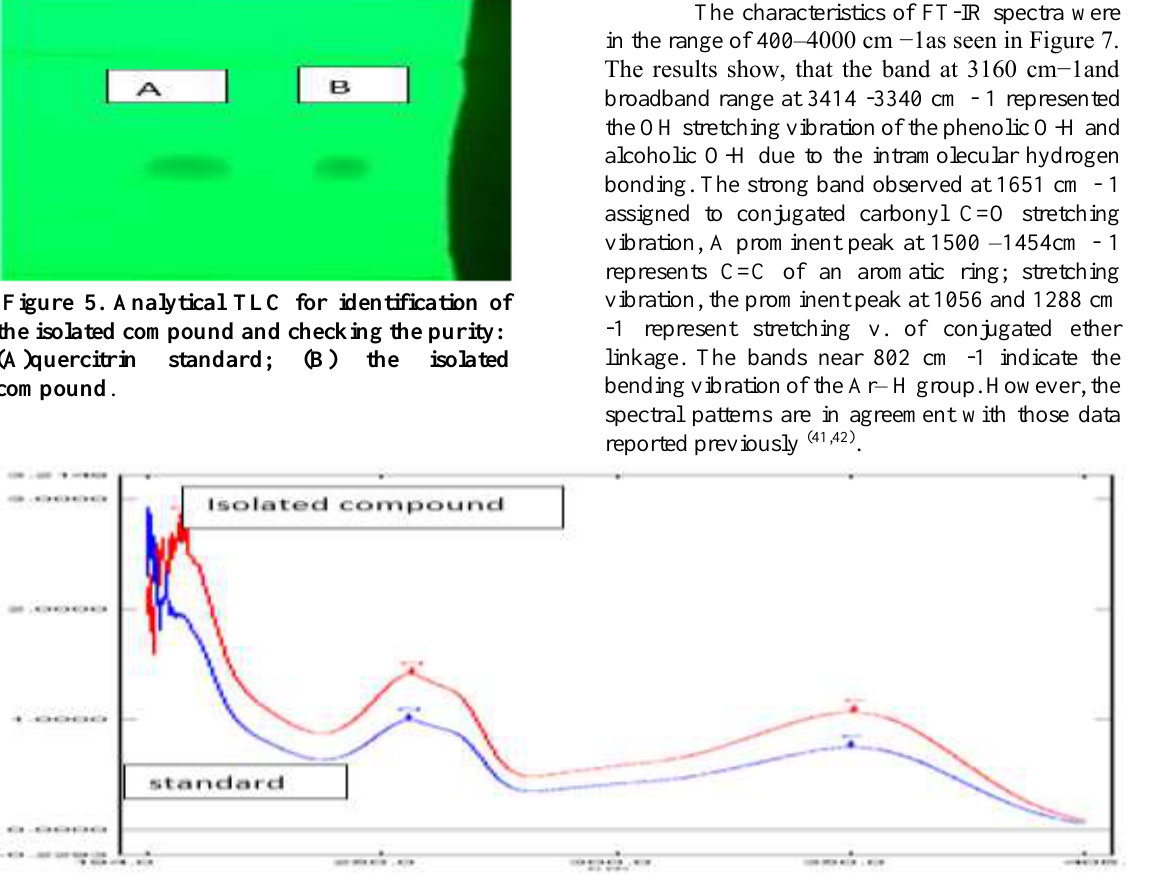
Figure 6. UV- Spectra of quercetin-3-O-rhamnoside compared with standard.